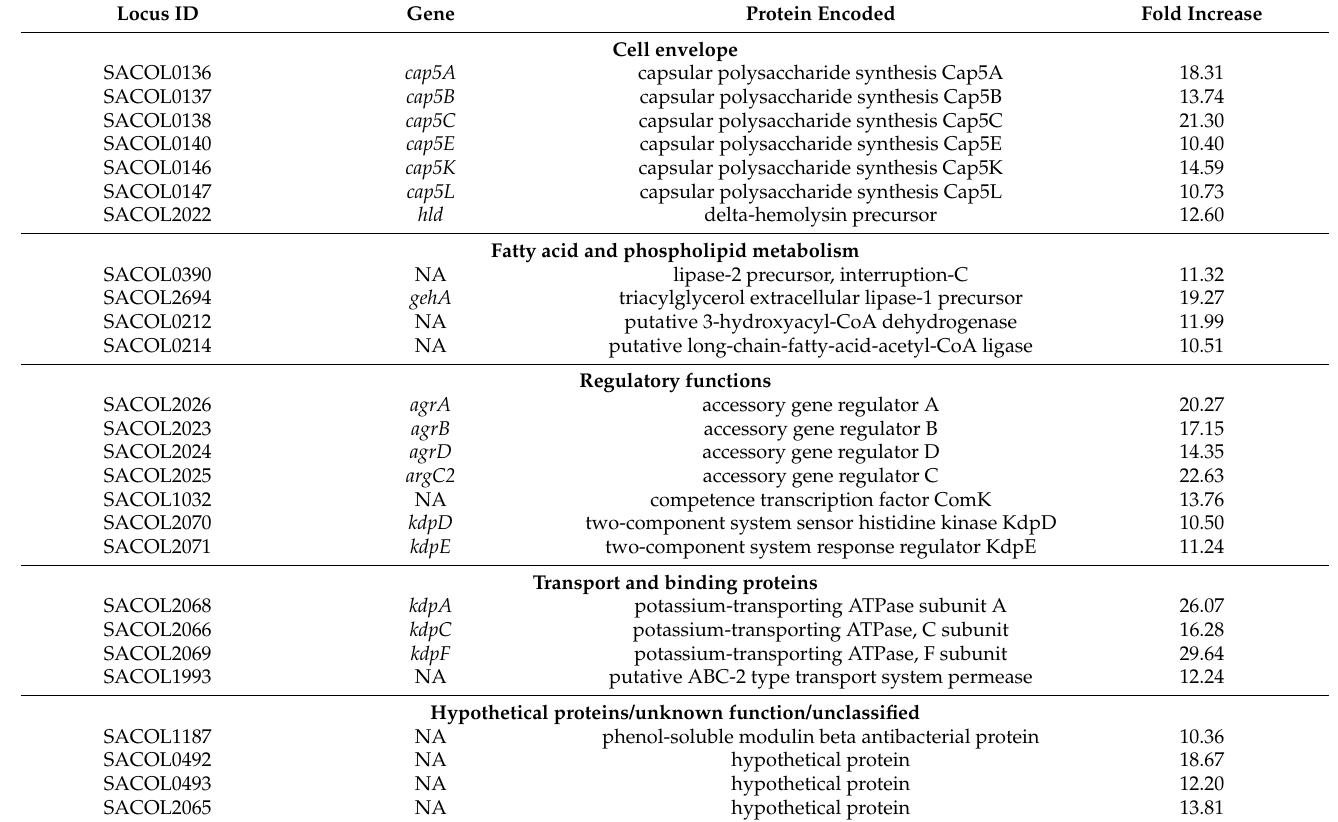
Table 4. Genes upregulated ≥ 10-fold in SH10001st-2 compared to SH1000. Locus ID